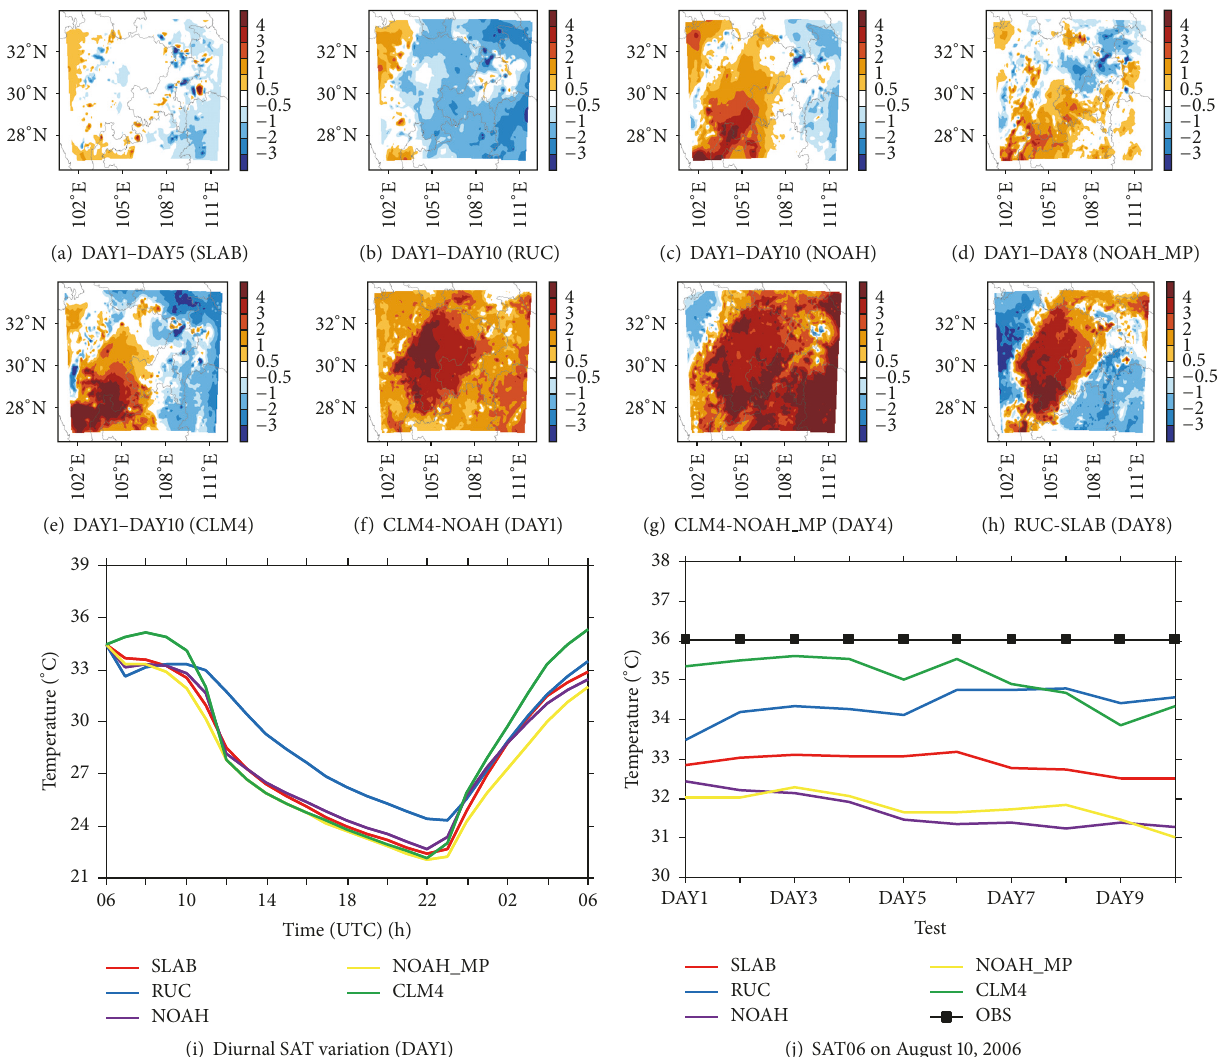
Figure 3: Distributions of SAT06 difference fields (unit: ∘ C) for August 10, 2006, due to different LSSs and simulation lengths (a–h) and the domain- (A3-) averaged DAY1 diurnal SAT variations (i) and SAT06